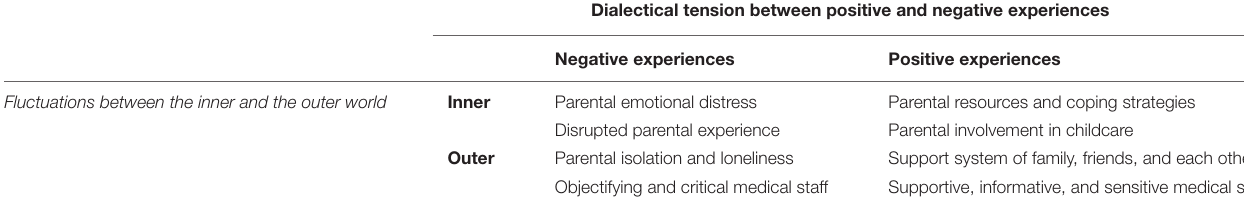
Dialectical tension between positive and negative